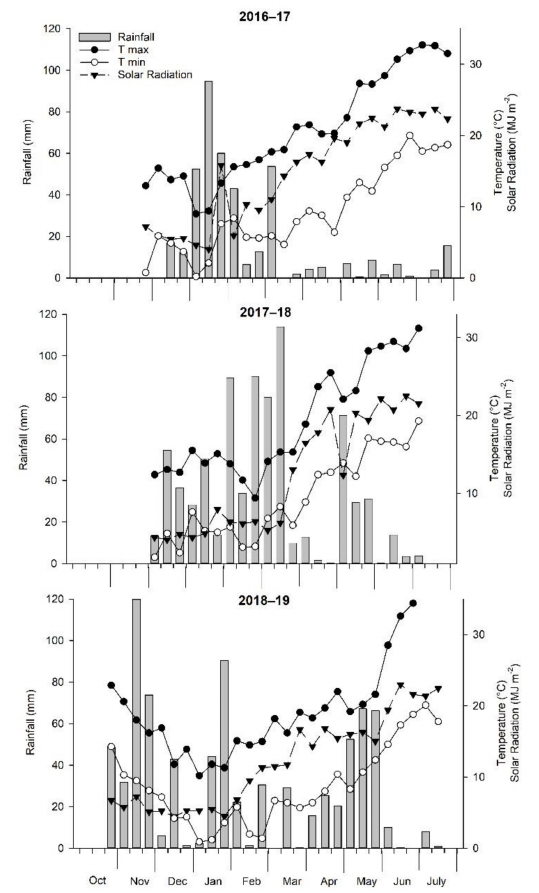
Figure 1. Rainfall, air temperature (Tmin and Tmax), and solar radiation distribution during the three experimental